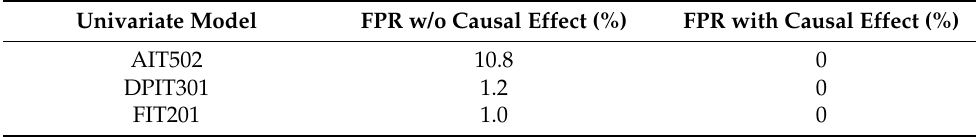
Table 4. False positive rates with and without causal effect estimation.